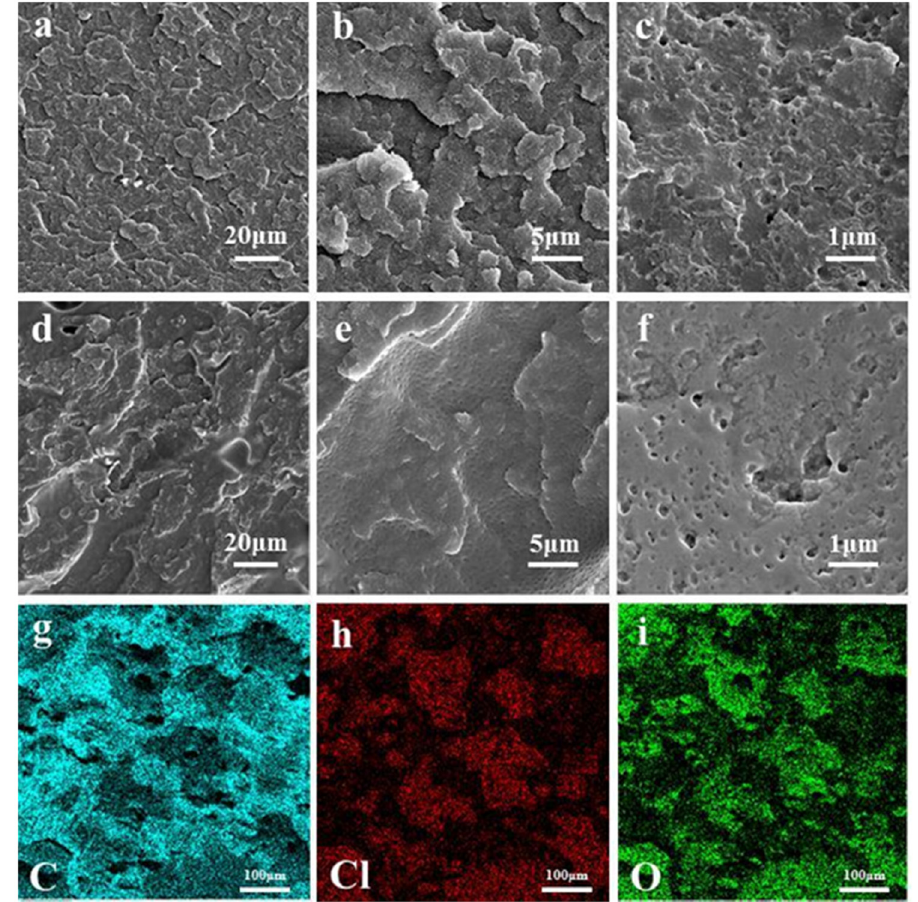
Figure 8: SEM photos of ( a – c ) neat ABS, ( d – f ) ABS with 20 wt% PDSH - 1091. EDS elemental maps of ( g – i ) ABS with 20 wt% PDSH -